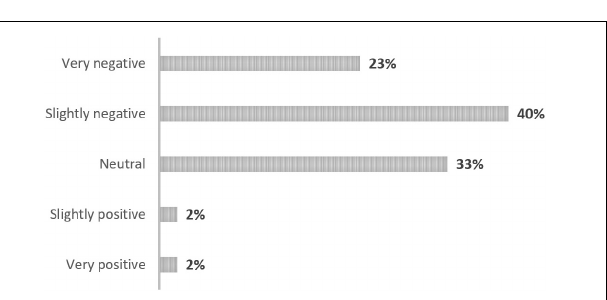
FIGURE 3 | Percentage of codes identified for the vocabulary used by participants that do experience tinnitus (black) and by participants that do not experience tinnitus (gray). Significant differences ( p < 0.05) are indicated by an asterisk (*).